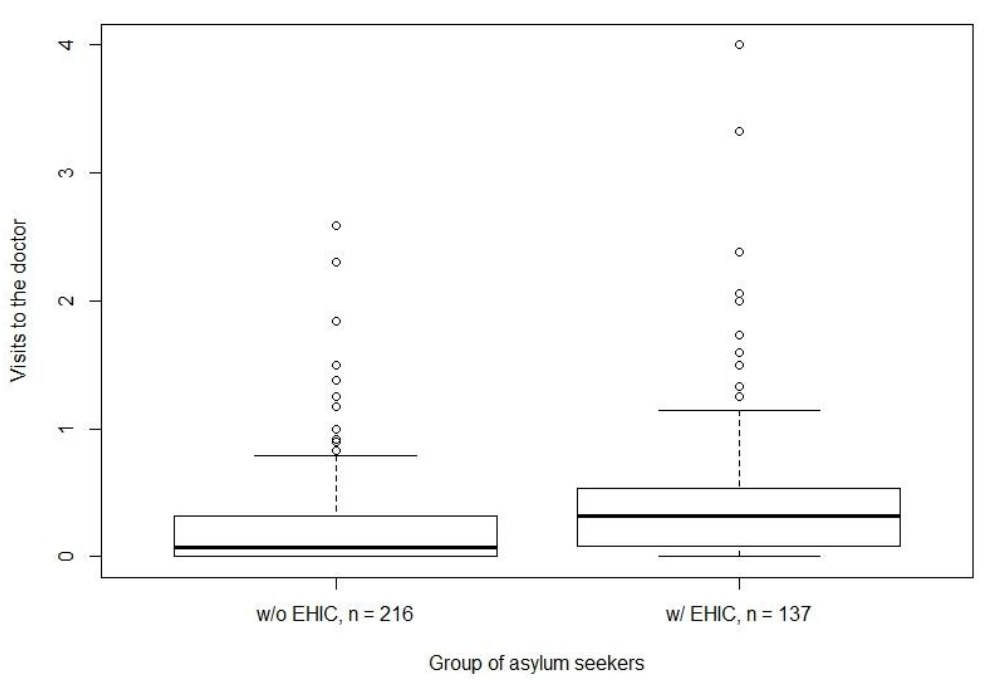
Figure 1. Consultation rate of ambulant physicians per month among a sample of asylum seekers in Germany stratified for ownership of the Electronic Health Insurance Card (EHIC) (with EHIC: n = 137, without EHIC: n = 216).